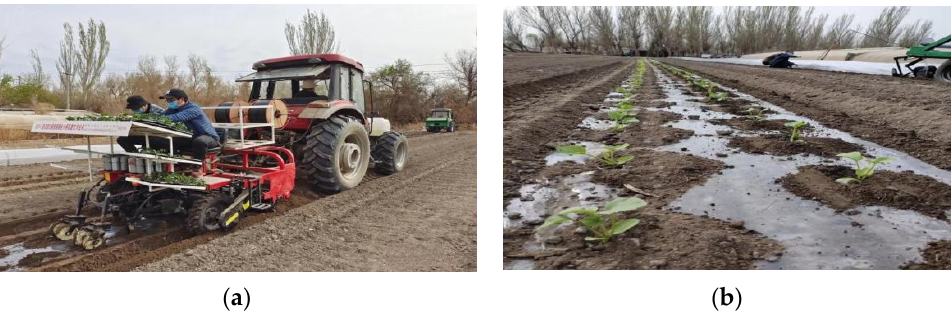
Figure 4. Field testing site. ( a ) Transplanter working test site. ( b ) The effect of transplanting canta- loupe.